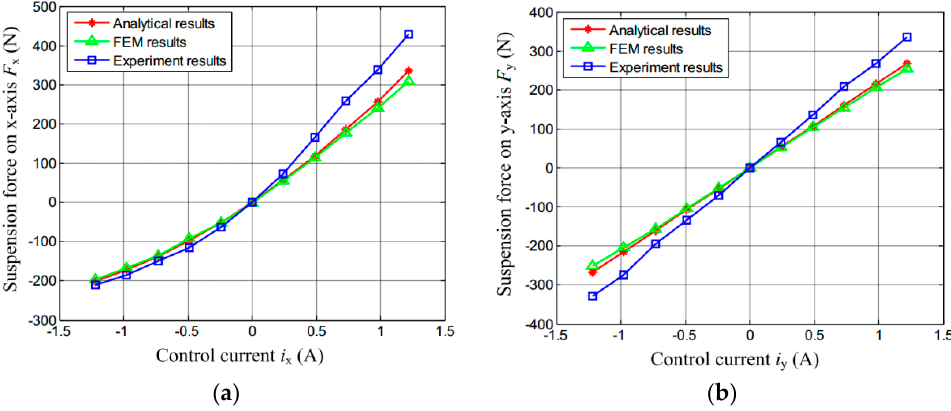
Figure 6. Suspension force ‐ current characteristics of analytical, finite element method (FEM) and experiment results. ( a ) Suspension force on x ‐ axis; ( b ) Suspension force on y ‐ axis.